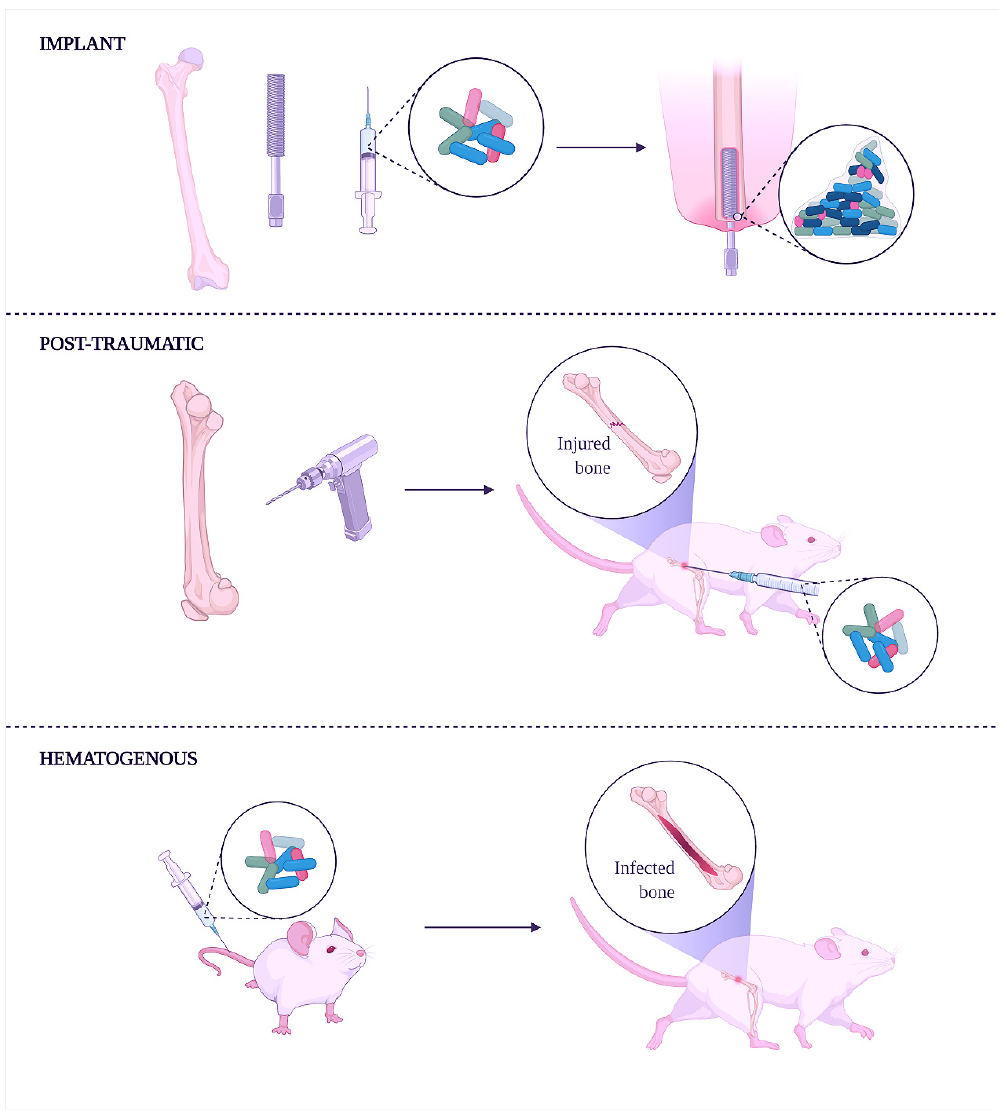
Figure 1. Experimental induction of human osteomyelitis in animal models.